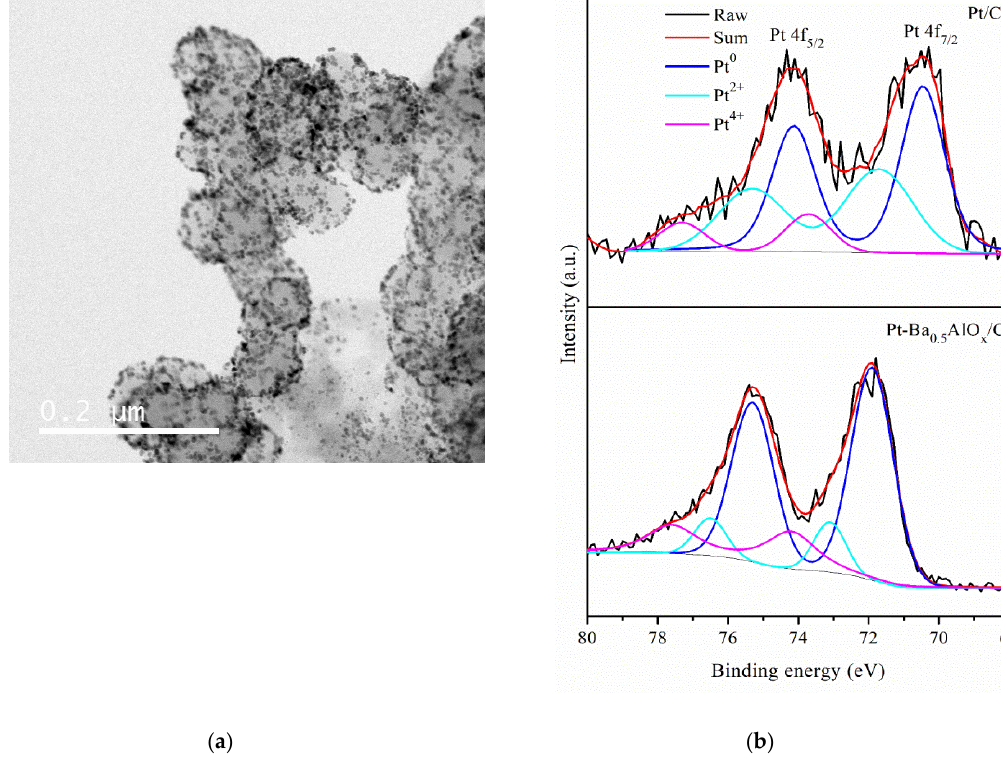
Figure 8. ( a ) TEM image of 20%Pt-Ba 0.5 AlO x / C and ( b ) Pt 4f XPS of two catalysts.